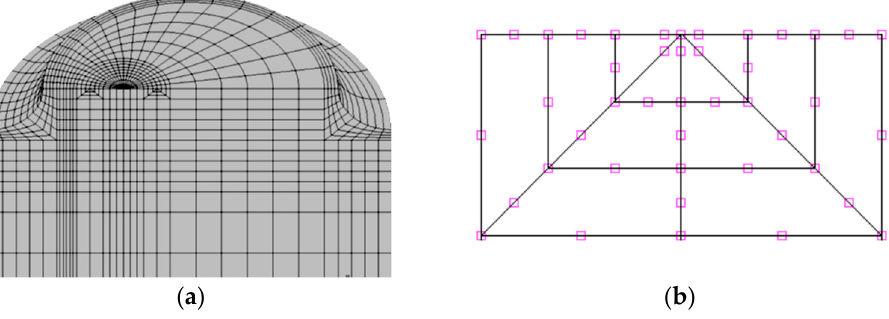
Figure 3. Finite element mesh: ( a ) 3D general view; ( b ) crack tip detail.